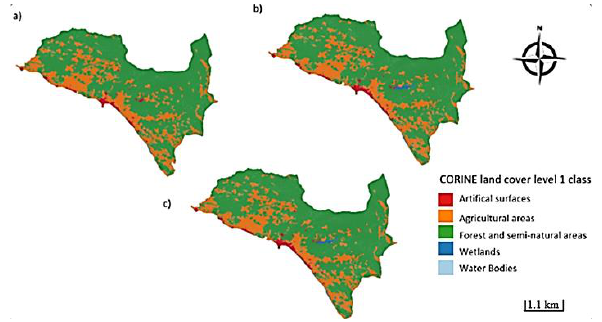
Figure 3 . CORINE, LULC maps obtained as a result of